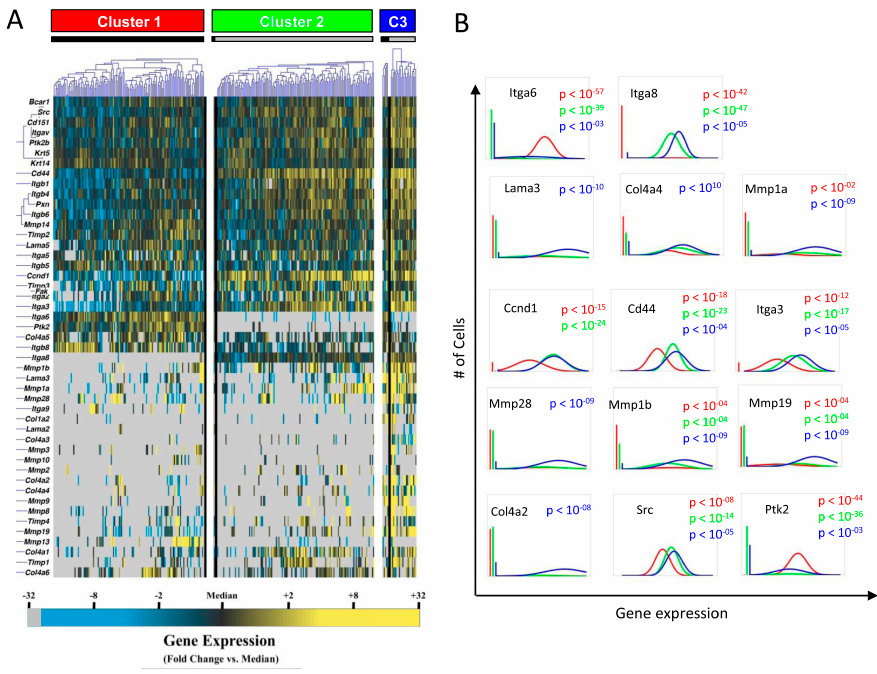
Figure 3. Partitional cluster analysis of single-cell transcriptional data. ( A ) K-means clustering of WT (black bar) and FAK-deleted keratinocytes (grey bar). Gene expression is presented as fold change from median on a color scale from yellow (high expression, 32-fold above median) to blue (low expression, 32-fold below median); ( B ) Differentially-expressed genes among cells in each cluster using non-parametric two sample Kolmogorov-Smimov testing across all (both WT and FAK KO) keratinocytes comprising each cluster, illustrated here using median-centered Gaussian curve fits. The left bar for each panel represents the fraction of qPCR reactions that failed to amplify in each group.